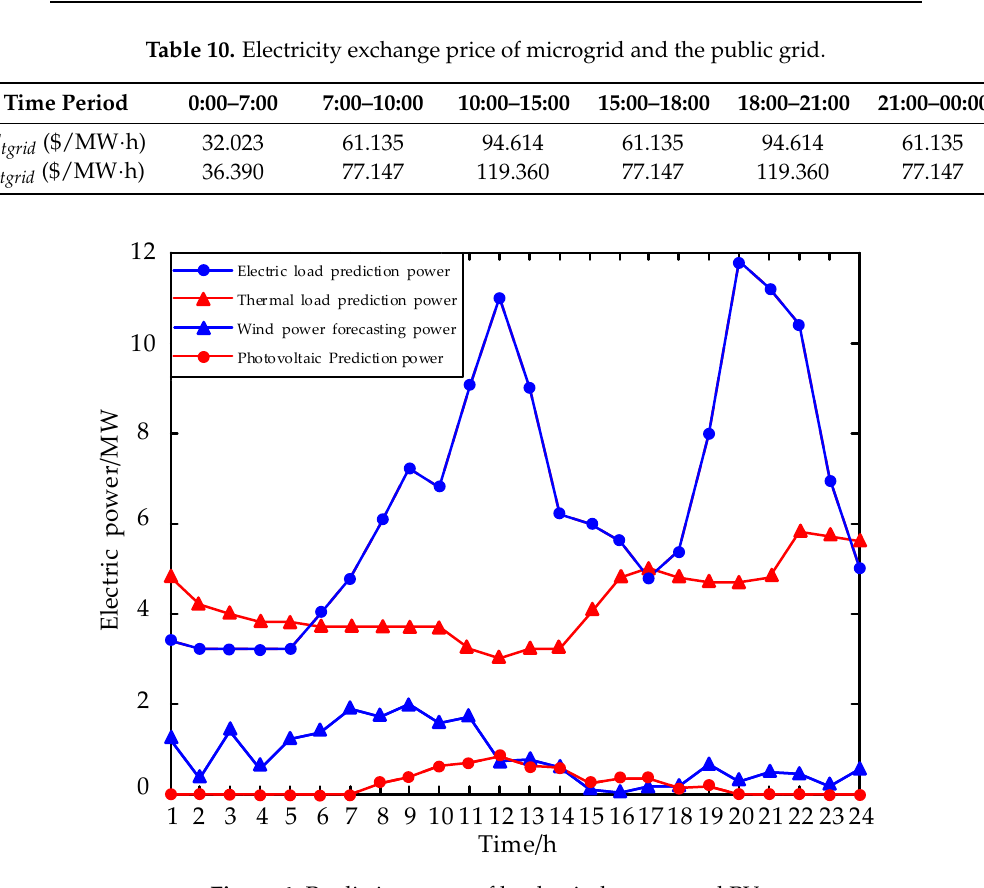
Figure 4. Prediction curve of load, wind power, and PV.